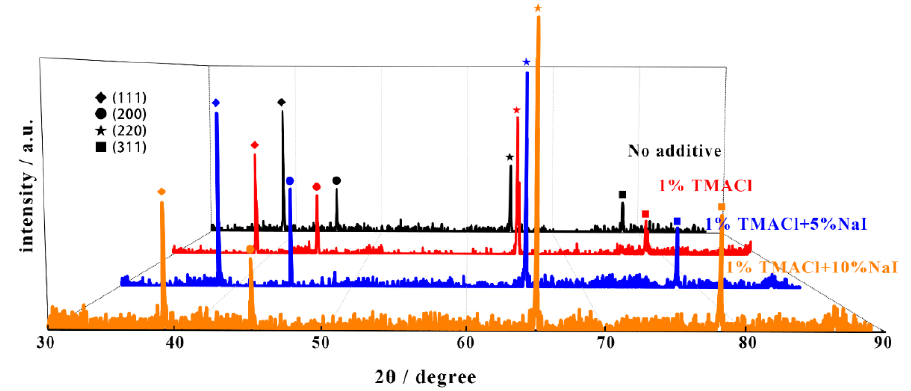
Figure 7. The cross-sectional morphology of the Al coating deposited from the AlCl 3 -NaCl-KCl molten salts electrolyte with different additives, ( a ) no additives, ( b ) 1% TMACl, ( c ) 1% TMACl + 5% NaI and ( d ) 1% TMACl + 10% NaI.